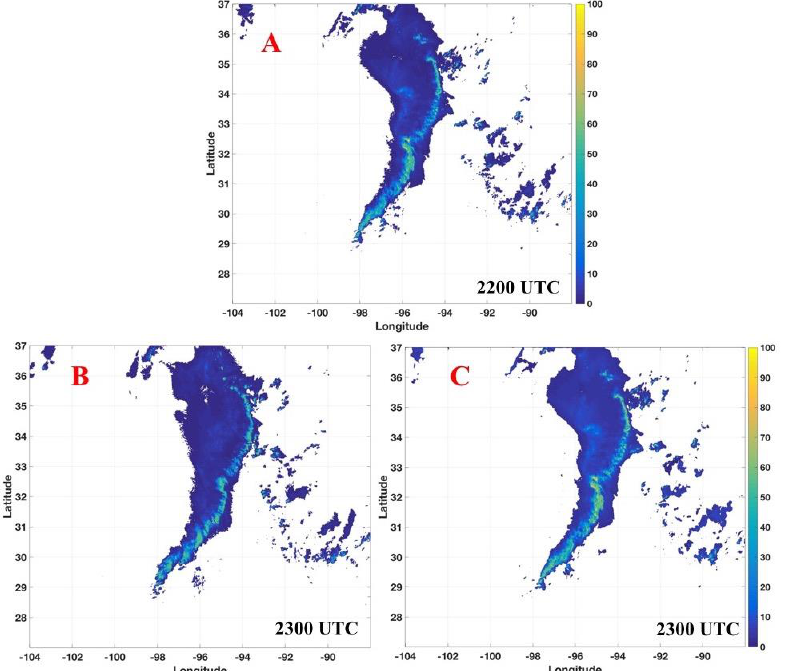
Figure 9. ( A ) QPE results at 2200 UTC; ( B ) QPE results at 2300 UTC; ( C ) prediction results at 2300 UTC.